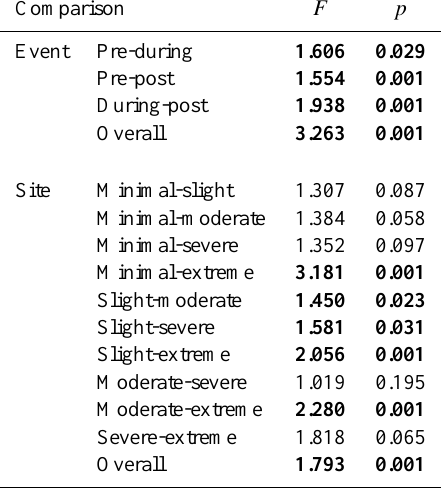
Table 4. Results of permutational MANOVA tests for compar- isons of macroinvertebrate communities grouped by event (pre-, during-, post-dewatering) and site (strength of dewatering impact). Statistically-significant community differences are in bold.